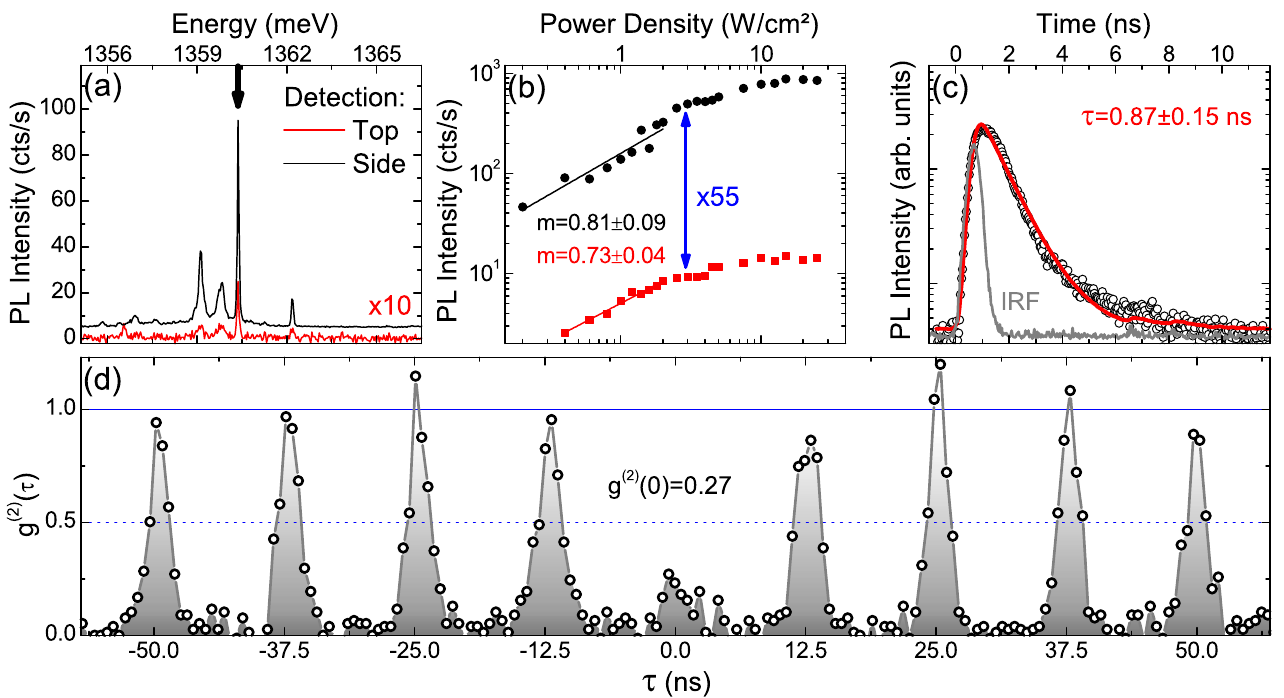
FIG. 3. (a) PL spectra of the single quantum dot recorded with detection from the top (black line) and from the side (red line). ¼ 1360 : 4 meV with detection from the top (black circles) and from (b) Power-dependent PL intensity of the single exciton line at E X the side (red squares). (c) Corresponding time-resolved PL intensity measurements with detection from the side (open circles). The solid red line is a fit to the data, and the solid gray line is the instrument response function of the excitation and detection system. (d) Corresponding photon autocorrelation measurement with detection from the side, proving the single-photon character of the emission. The excitation power density for this measurement is 4 W = cm 2